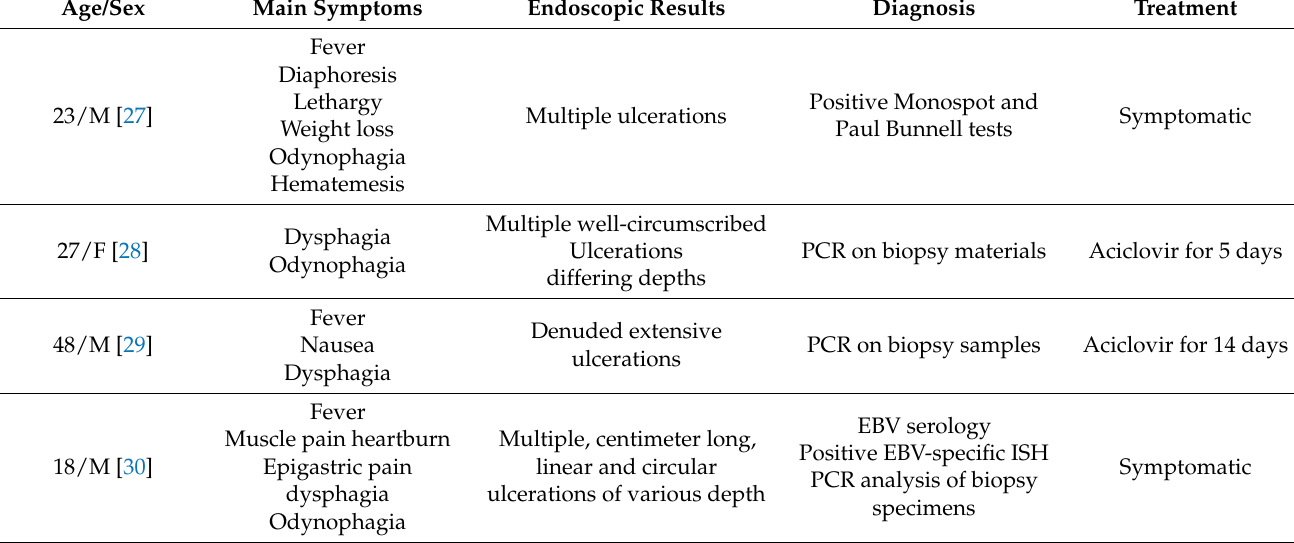
Table 1. Summary of reported cases of EBVMCU in